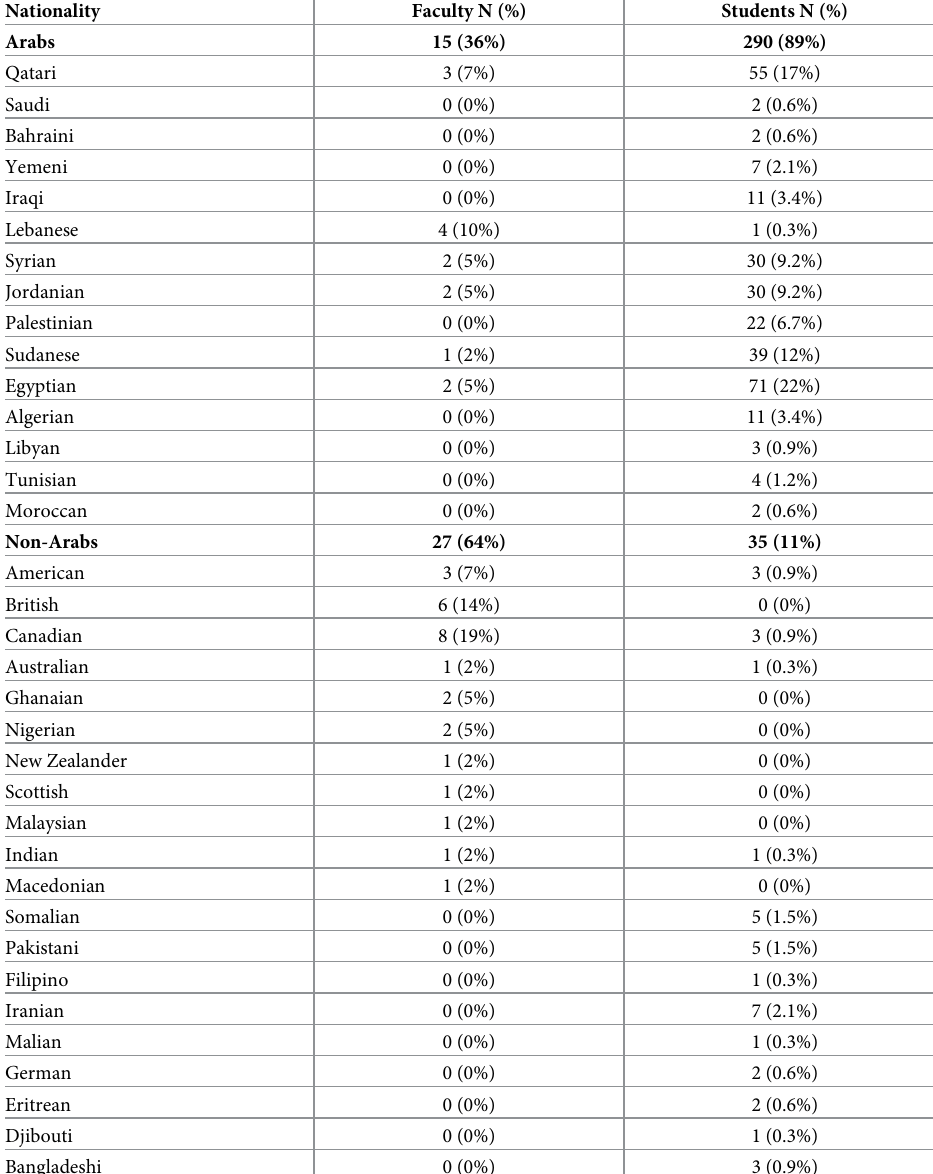
Table 1. The CPH’s instructor and student